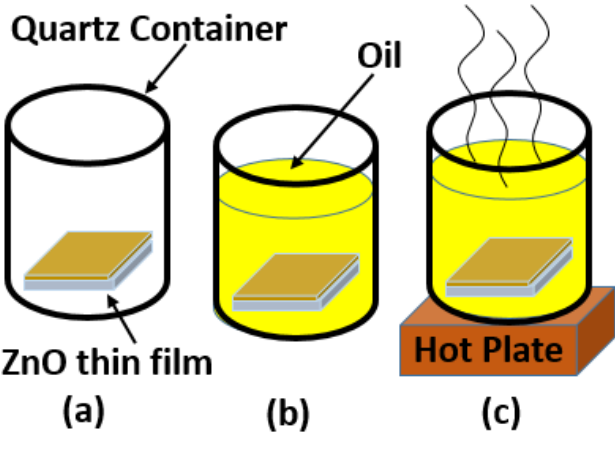
Figure 2: OTA process diagram of the stages treatment a) Putting sample inside the container b) Fill the container with oil c) Oil heat to the desired temperature